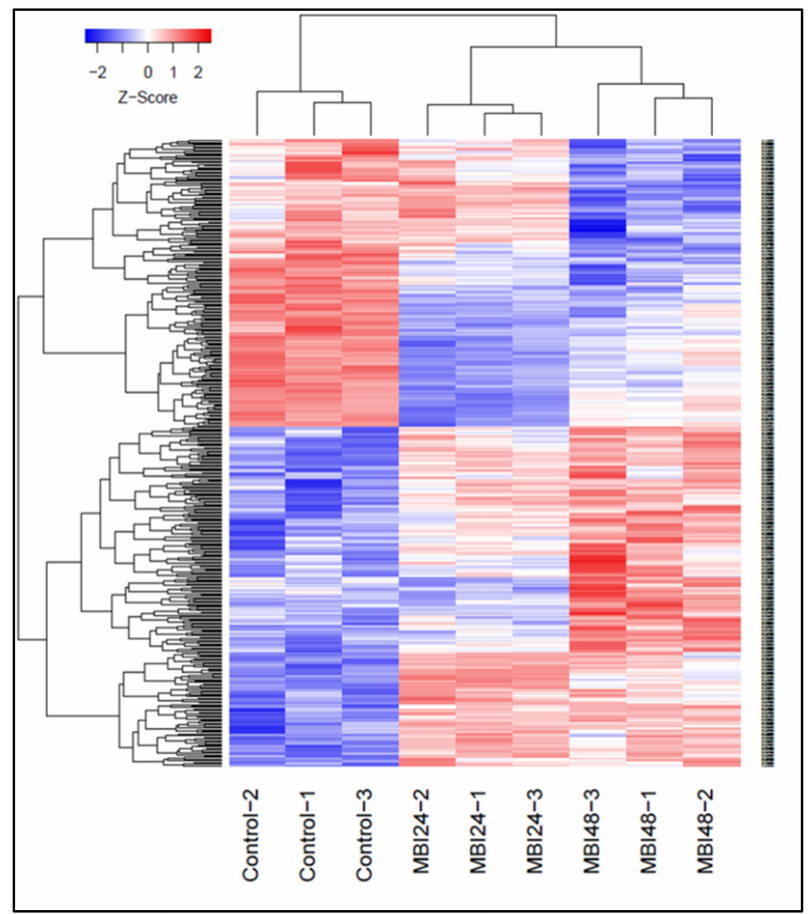
Figure 2. Genes that displayed a greater than two-fold difference ( p < 0.05) in expression were identified and plotted in a heat map, and the gene expression in conditions and time points was compared. Red and blue colors represent genes with up expression or down expression values,